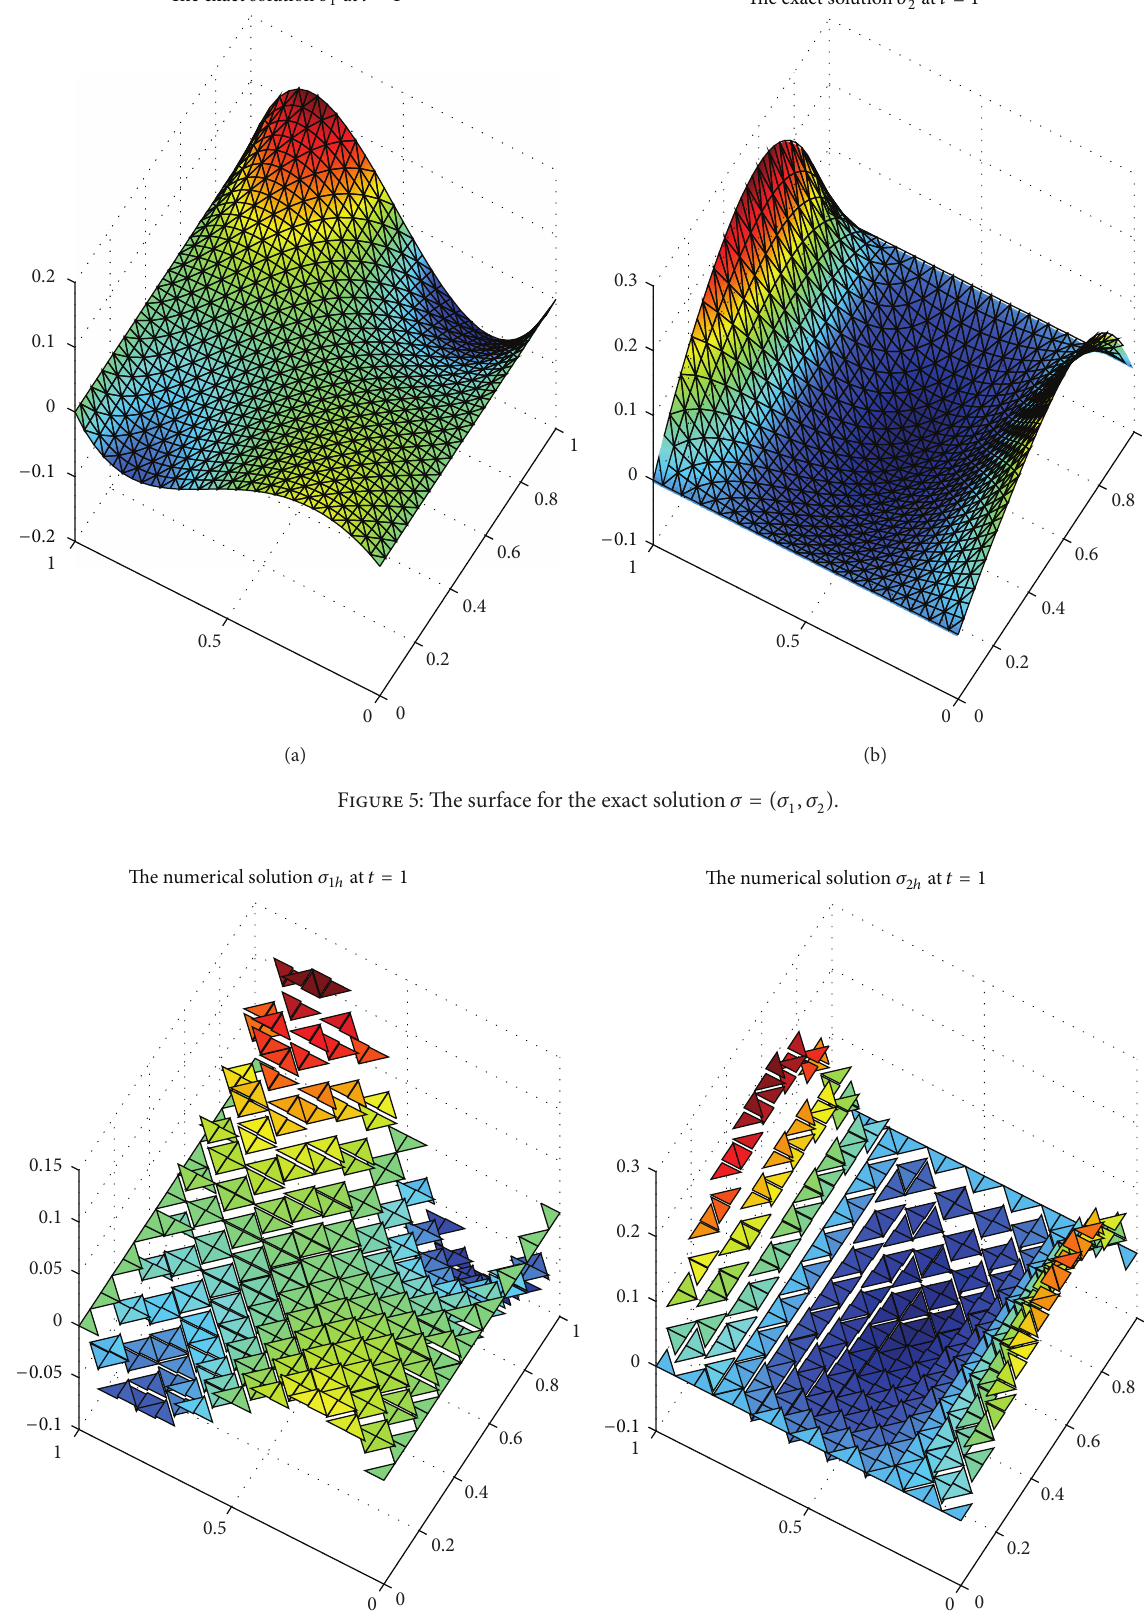
Figure 6: The surface for the numerical solution 𝜎 ℎ = (𝜎 1ℎ ,𝜎 2ℎ )